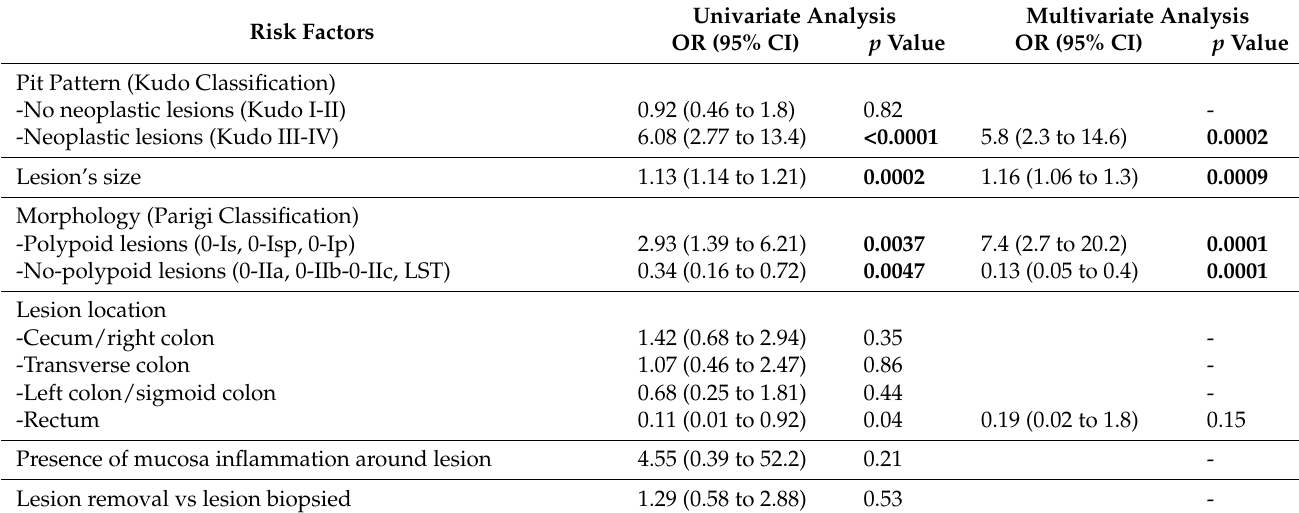
Table 4. Predictive endoscopic features associated with risk of dysplasia.